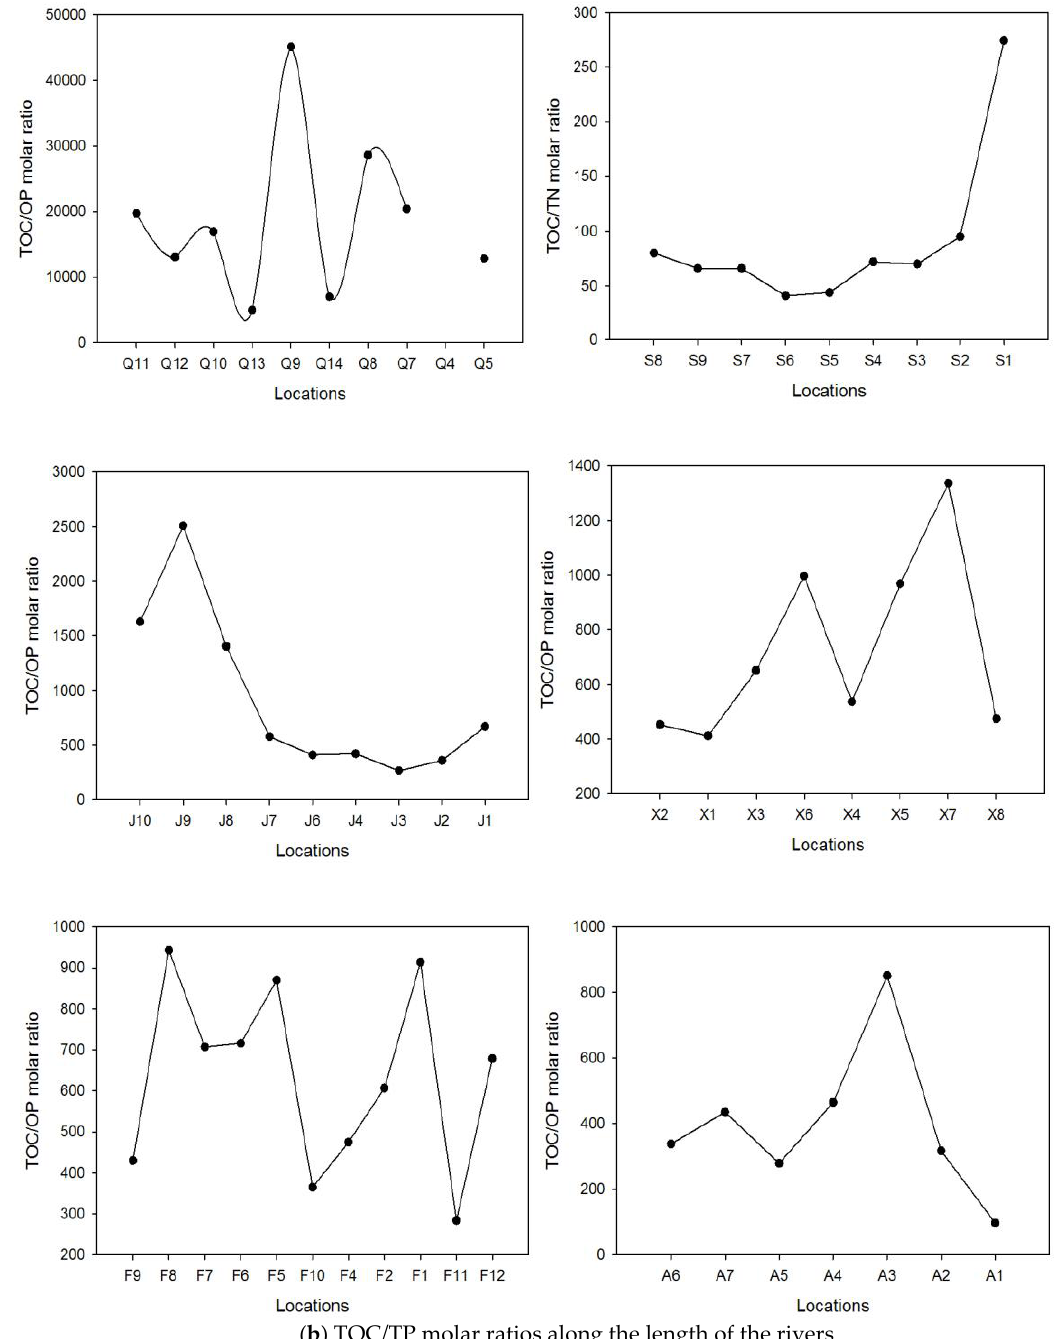
Figure 6. Spatial distribution of ( a ) sedimentary P species and ( b ) TOC/OP molar ratios along the Qiantang (Q), Shuang (S), Jiao (J), Ximen (X), Feiyun (F) and Ao (A) Rivers.